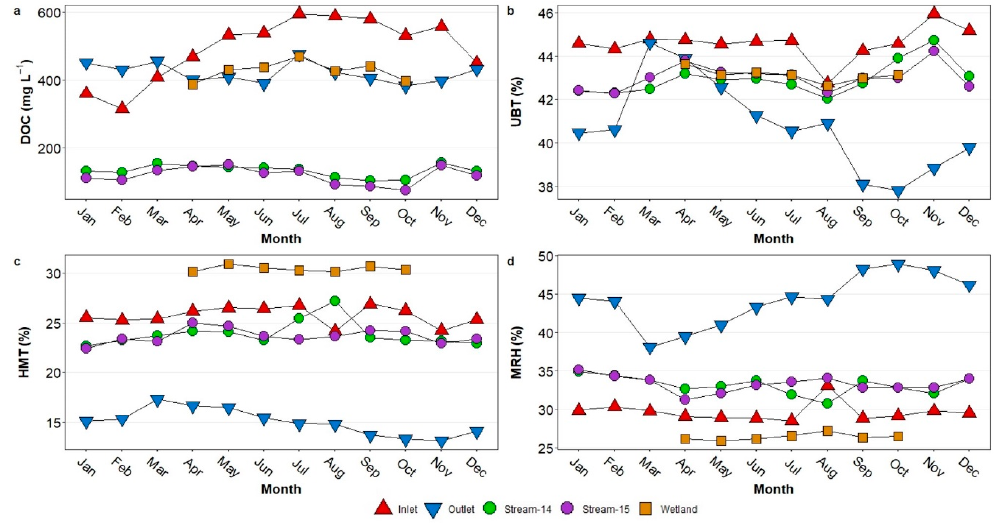
Figure 5. Average monthly values for ( a ) DOC (mg C L − 1 ); ( b ) ubiquitous terrestrial (UBT%); ( c ) high molecular weight terrestrial (HMT%); ( d ) microbial reprocessed humic-like (MRH%) in surface waters at the Arbutus Lake watershed.